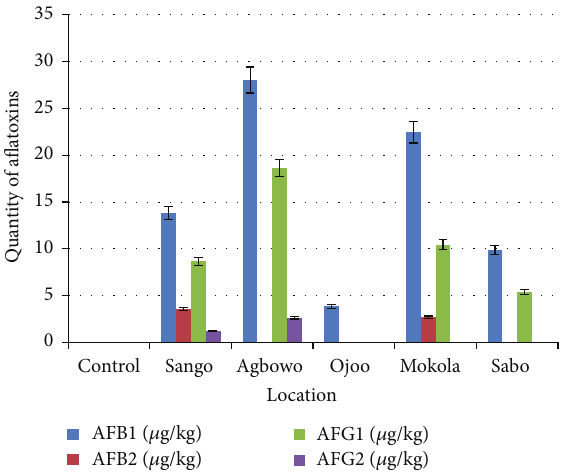
Figure 2: Aflatoxin Quantification of samples of “Suya spices” with percentage